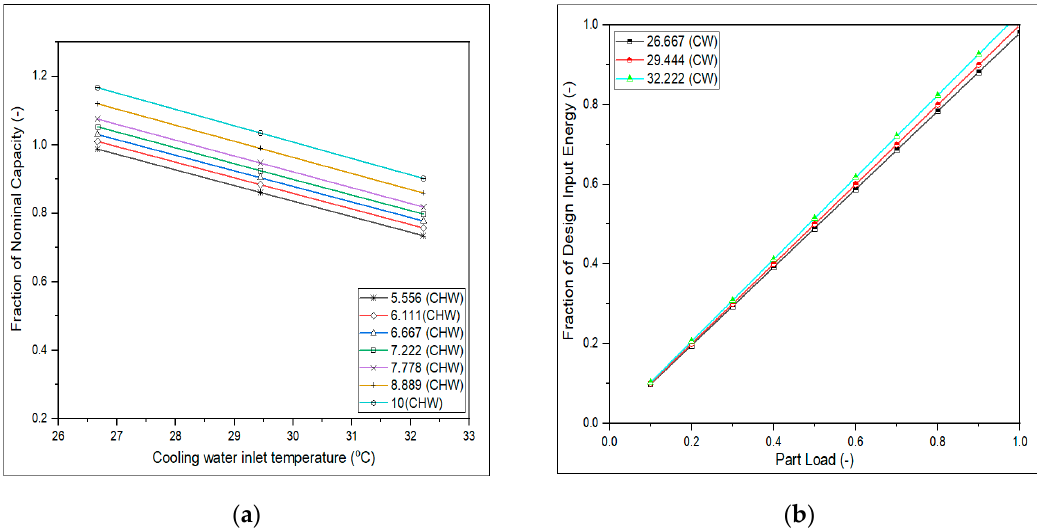
Figure 6. ( a ) Fraction of nominal capacity with varying cooling water inlet temperature at different chilled water temperatures for absorption cooling system (ACS); ( b ) fraction of design input energy at different part load ratio for ACS .